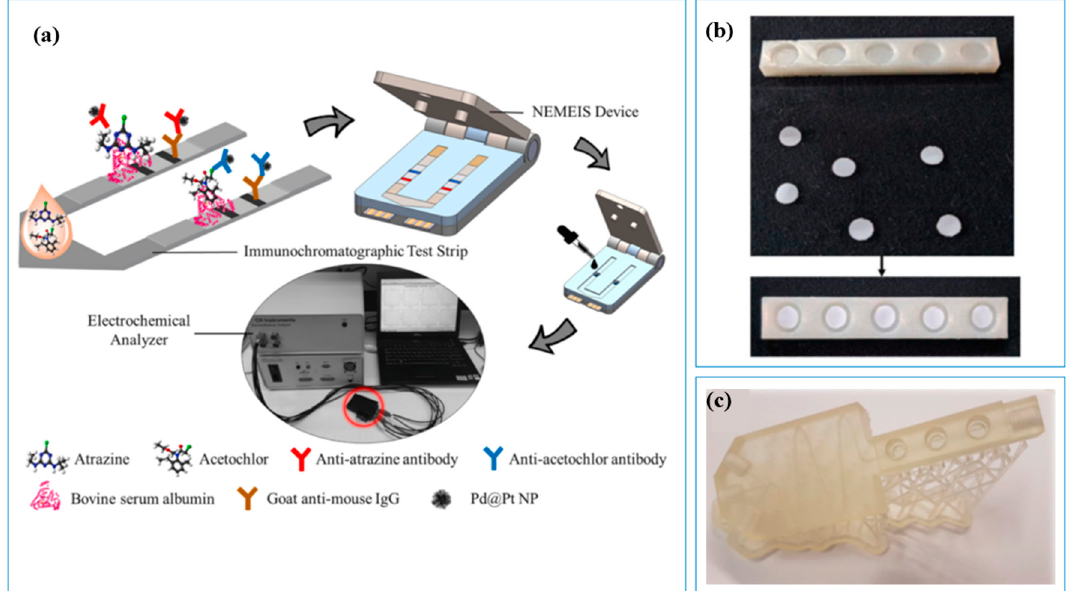
Figure 6. Three-dimensional-printed sensor platforms for muti-component analysis. ( a ) Electro- chemical system [46]; ( b ) Three-dimensional-printed support with paper-based sensor [47]; ( c ) Three-dimensional-printed flow manifold [13] .